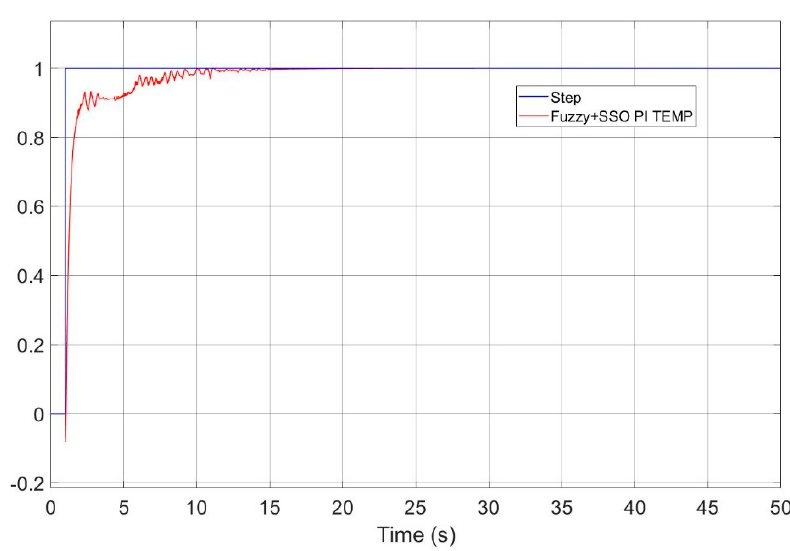
Figure 22. Flow versus time plot for PI tuned with SSO and SSO fuzzy. Appl. Sci. 2020 , 10 , x FOR PEER REVIEW